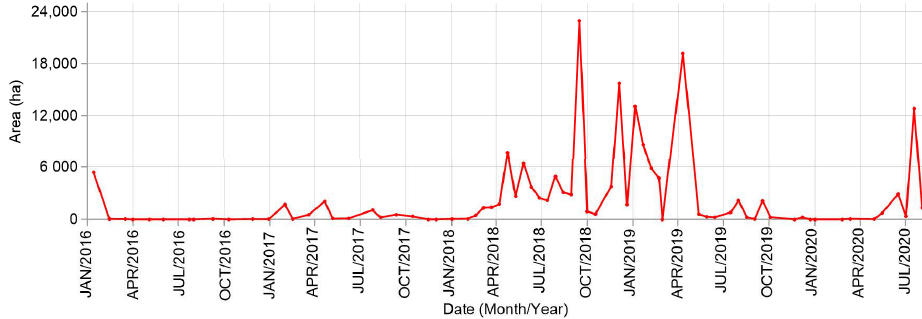
Figure 5. Time series of sargasso cover in the study area, detected by Landsat 8 imagery, 2016–2020.